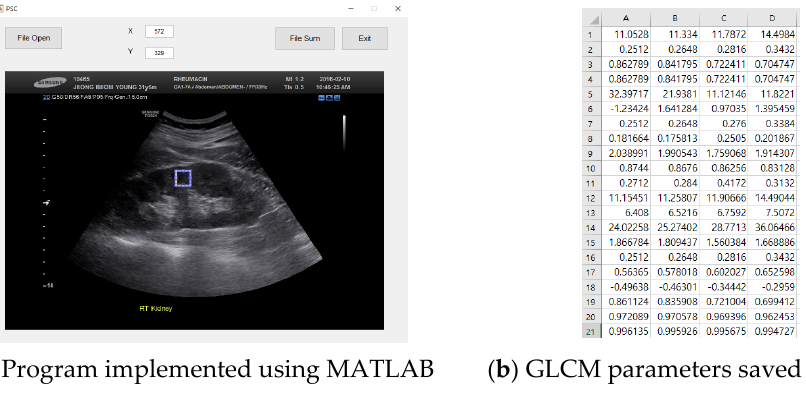
Figure 3. Program implementation.